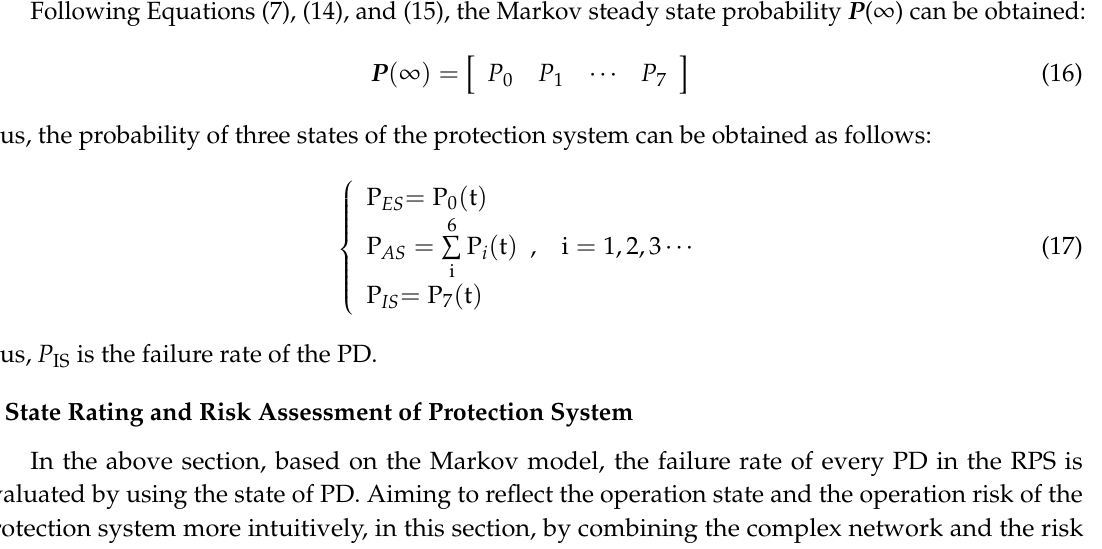
Figure 4. Risk network diagram of substation protection system.